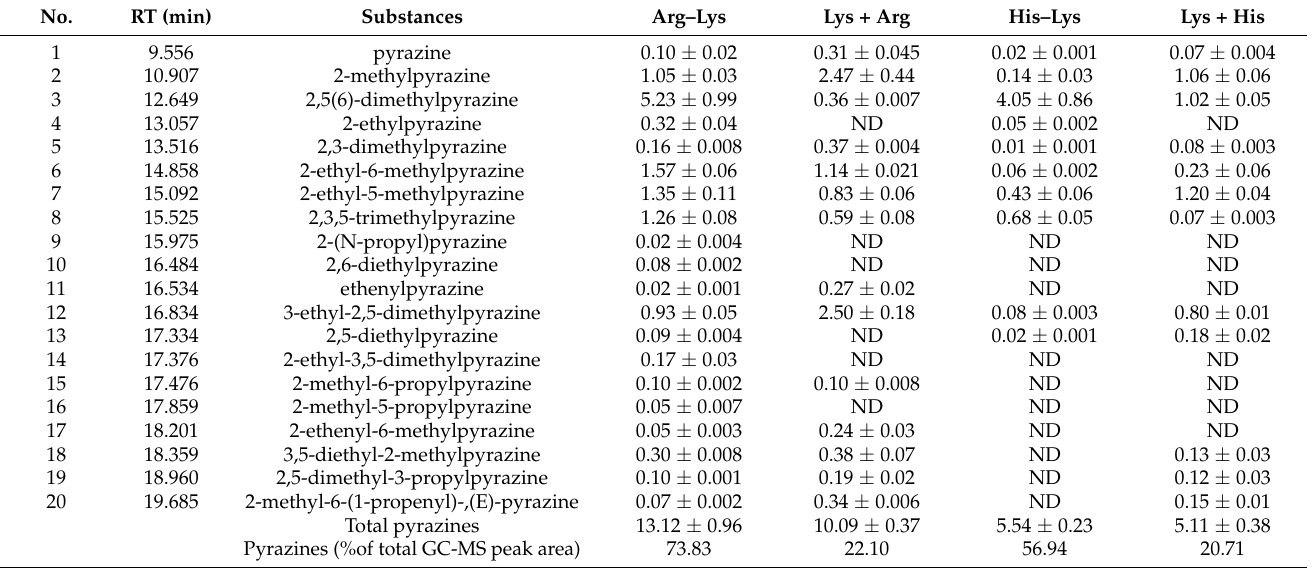
Table 1. Pyrazines contents ( µ g/g) in the model system (glucose with X − Lys dipeptides) and in the Control (Arg + Lys) and Control (His + Lys) ( p <